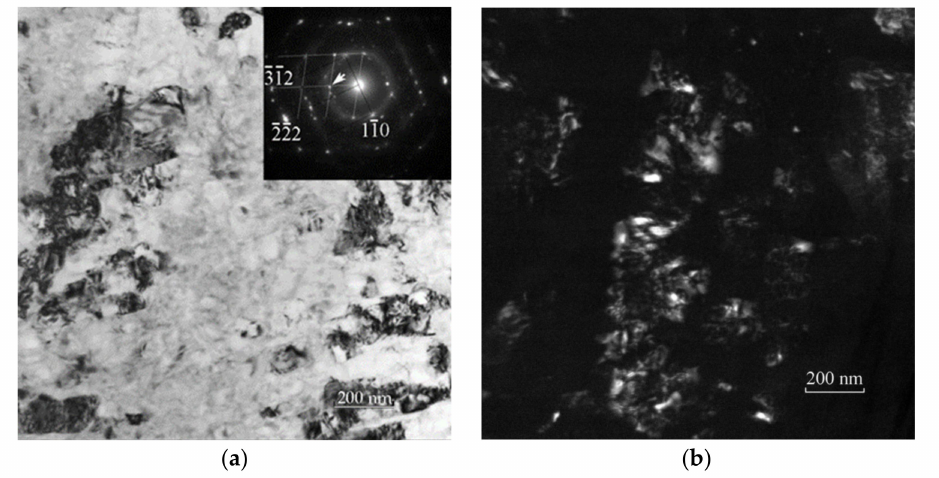
Figure 4. R-phase in substructure: ( a ) bright-field image with complex contrast created by Ti 3 Ni 4 particles, dislocations, and R-phase; corresponding microdiffraction pattern, zone axis [112], reflec- tions from B2-phase are indexed, R-phase reciprocal lattice section are indicated by white lines ( b ) corresponding dark-field image in R-phase reflection (310) are indicated by white arrow on ( a ) with visible phase